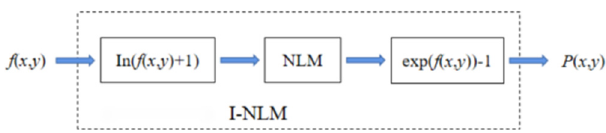
Figure 5. Flowchart of I-NLM filtering process.